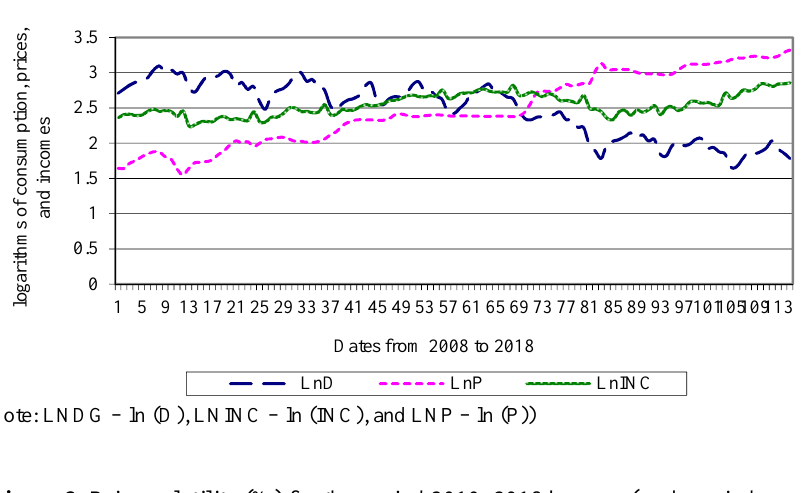
Figure 1. Graphs time-series logarithms of consumption, prices, and incomes